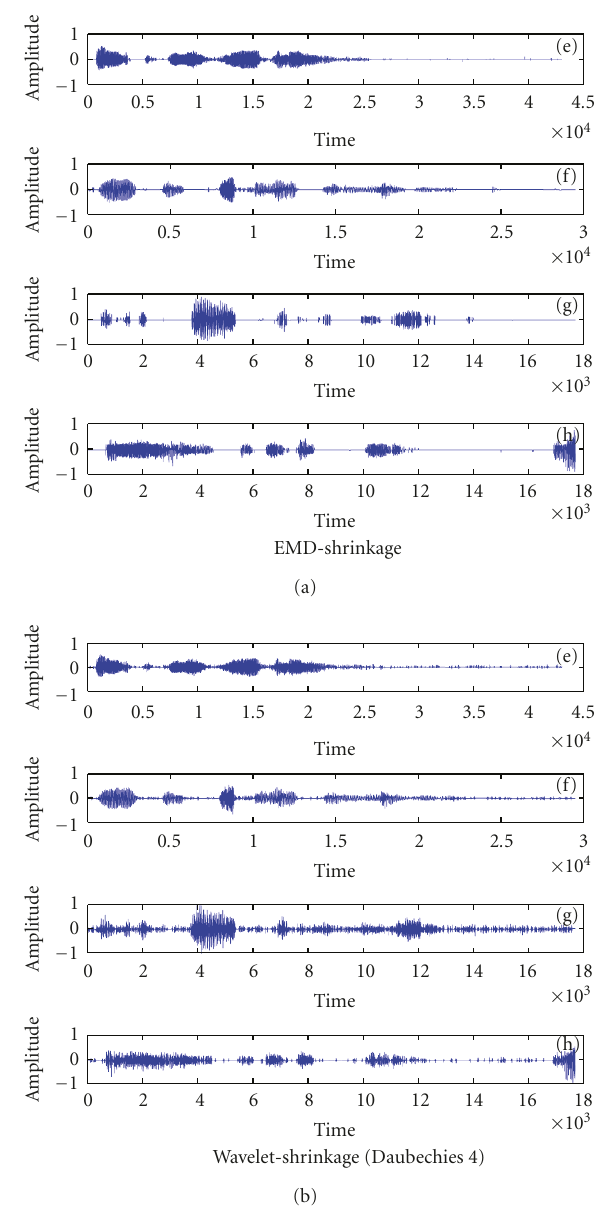
Figure 7: Denoising results of signals “e”, “f”, “g”, and “h” by the EMD-shrinkage and the wavelet approach (Daubechies